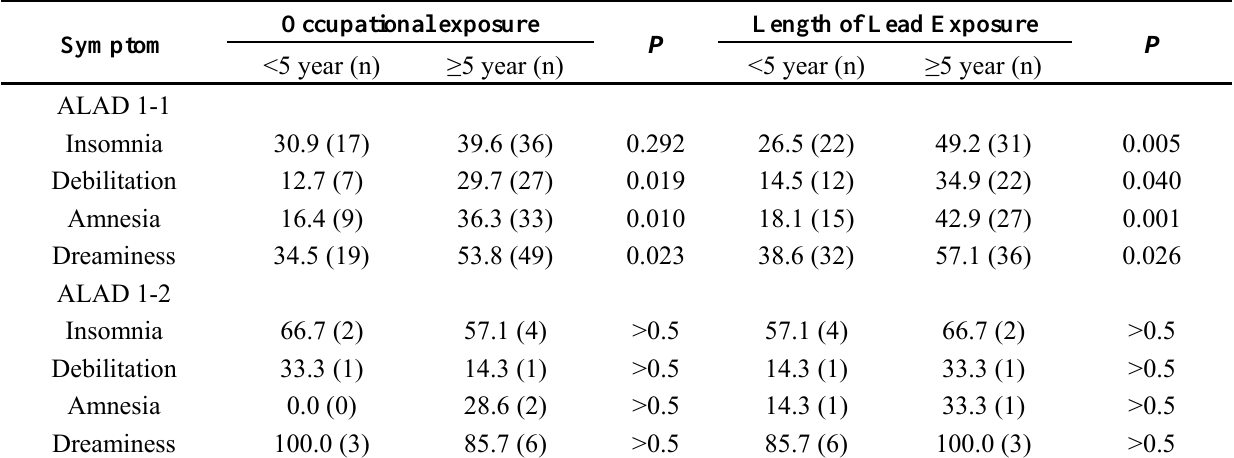
Table 3. Self-conscious symptom incidences with different ALAD genotypes, occupational exposure and lead exposure stratification (%). Occupational exposure Length of Lead Symptom P